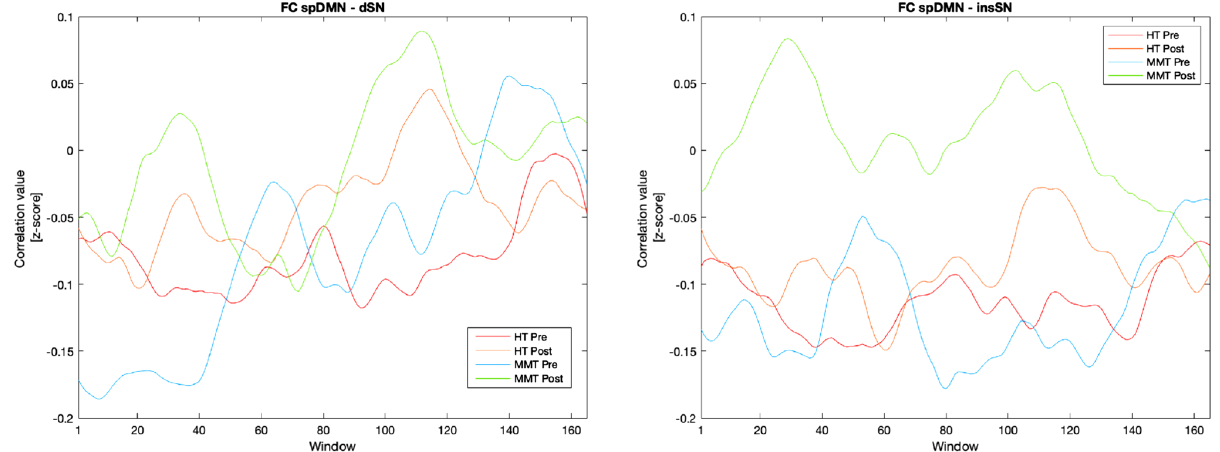
Figure 3. Group level Fisher r-to-z transformed correlation values between superior posterior default mode network (spDMN) and dorsal salience network (dSN) and between spDMN and insular salience network (insSN) across sliding windows. HT Health Training, MMT Mindfulness Meditation Training.